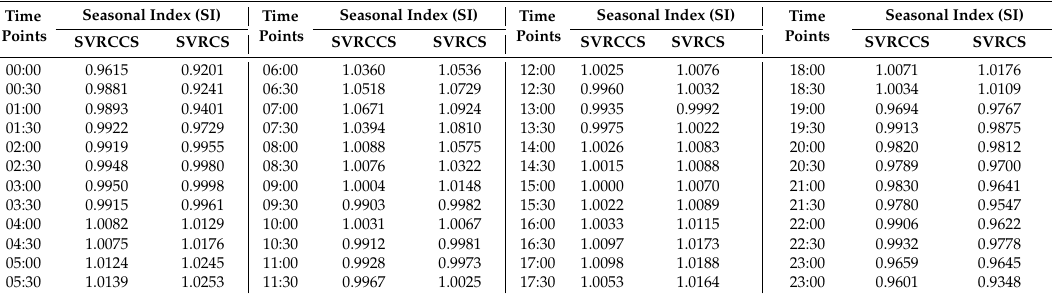
Table 2. The 48 seasonal indexes for SVRCCS and SVRCS models for Example